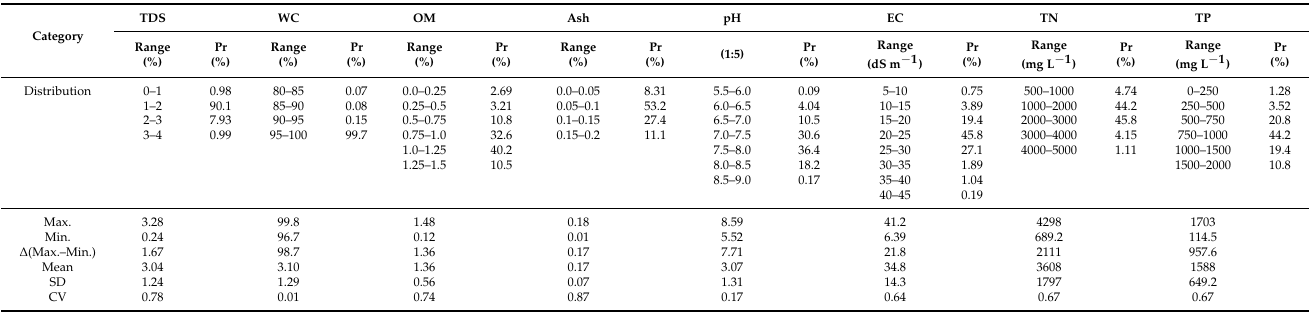
Table 2. Distribution and descriptive statistics of physical and chemical properties of FSS after separation of solid substances from RSS for 37 public livestock waste recycling